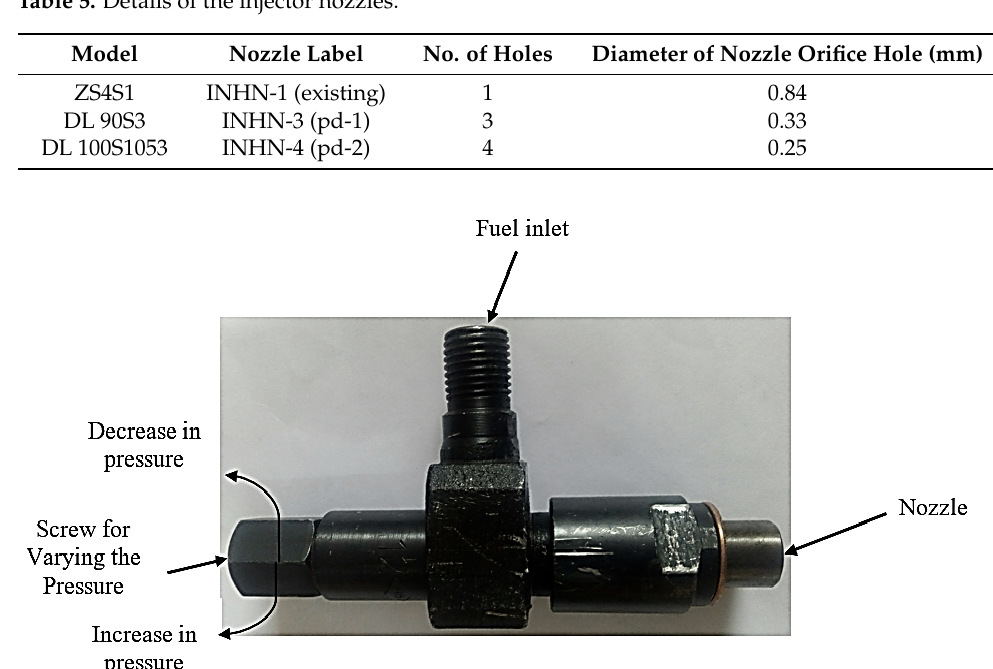
Figure 8. R180 diesel engine fuel injector assemblies.